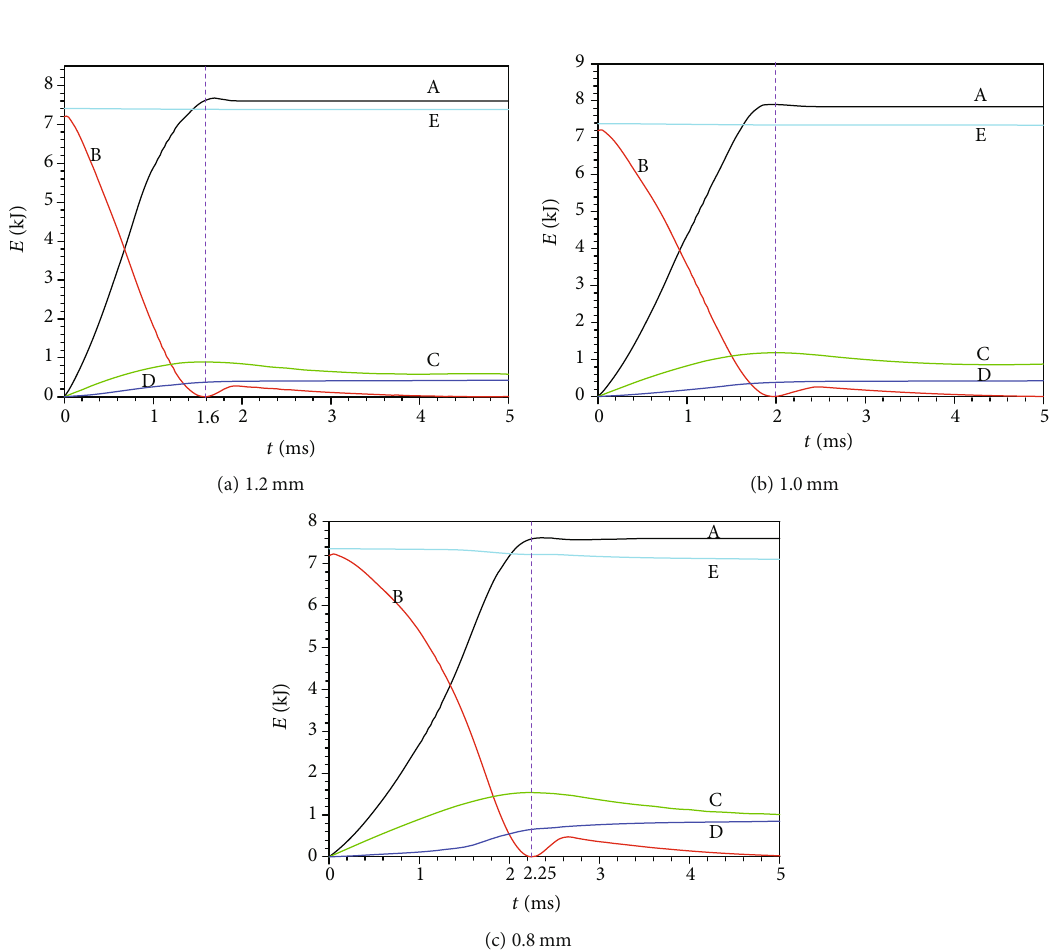
Figure 6: Energy conversion curves in the compression and energy absorption process of metal tubes of di ff erent wall thicknesses. A: internal energy of the metal tube; B: kinetic energy of the ascending object; C: work done under external load; D: frictional energy consumption; E: total energy of the